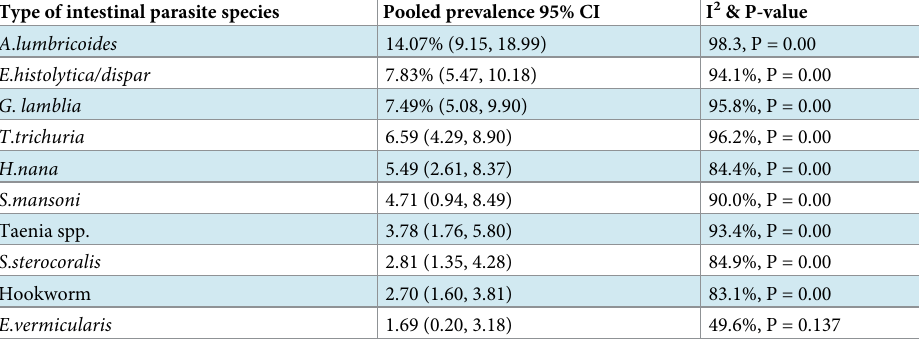
Table 3. Pooled prevalence of intestinal parasitic infection among street dwellers and prison inmates by intestinal parasites